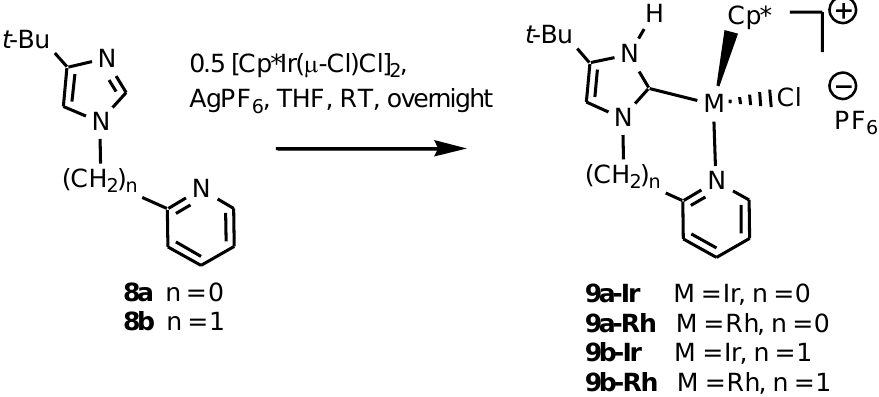
Scheme 2. Optimized room temperature formation of PNHC complexes of form 9 from 8a and 8b ,